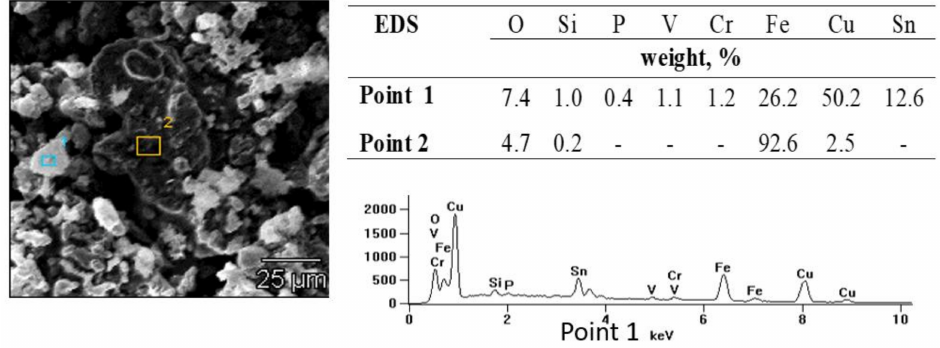
Figure 7. SEM image and EDS elemental analysis for a sample with HCl + O 3 after